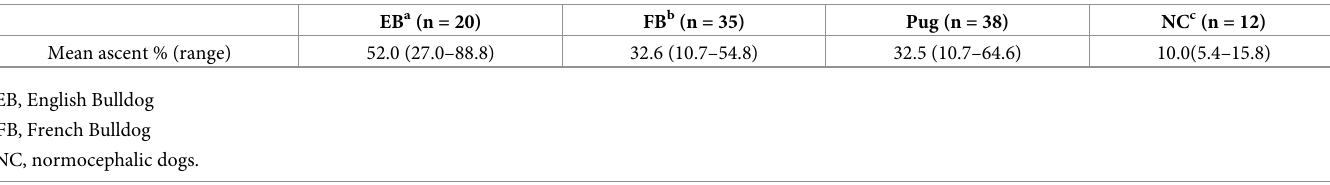
Table 1. NLD gradient percentage in 10 English Bulldogs (bilaterally in all cases), 18 French Bulldogs (17 bilaterally, one unilaterally), 20 Pugs (18 bilaterally, two unilaterally), and six normocephalic dogs (bilaterally in all cases). The NLD of normocephalic dogs ascends slightly in comparison to the ducts of English Bulldogs, French Bulldogs and Pugs, which exhibit a steep slope.